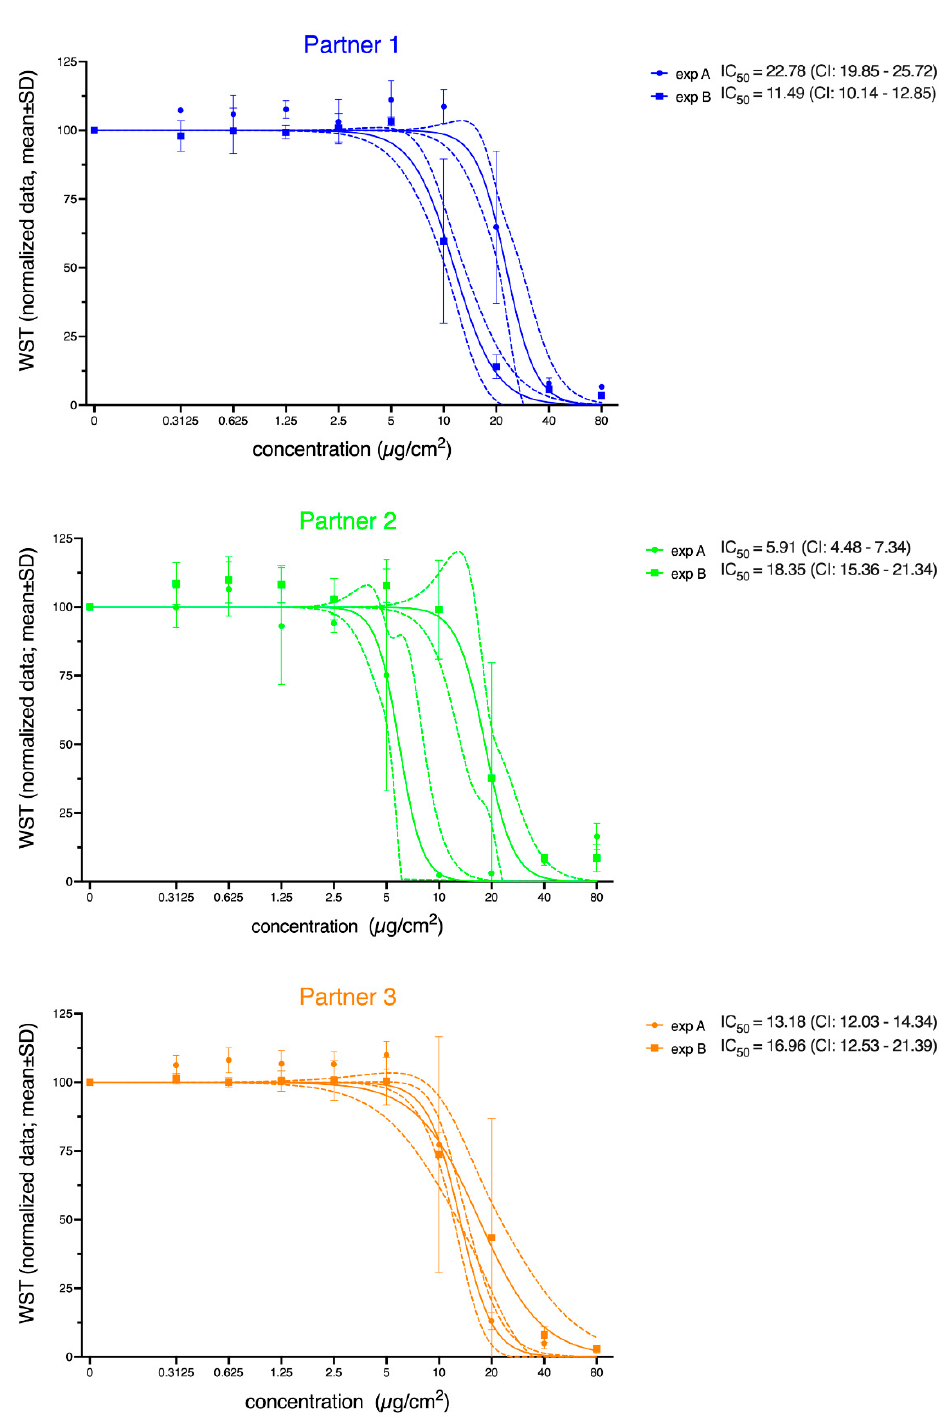
Figure 2. Viability of A549 cells, as indicated by the WST-1 assay after 24 h of exposure to NM110 (ZnO). Normalized data are presented corresponding to measurements performed by the various experimenters (exp A/B) at the participating institutes (Partners 1–3). Solid lines represent the nonlinear regression based on the calculated mean values; dashed lines represent the corresponding 95% confidence bands. The calculated IC 50 values are given in the figure legends along with the corresponding confidence intervals (CIs). The concentration is the administered concentration of the ENMs based on the initial